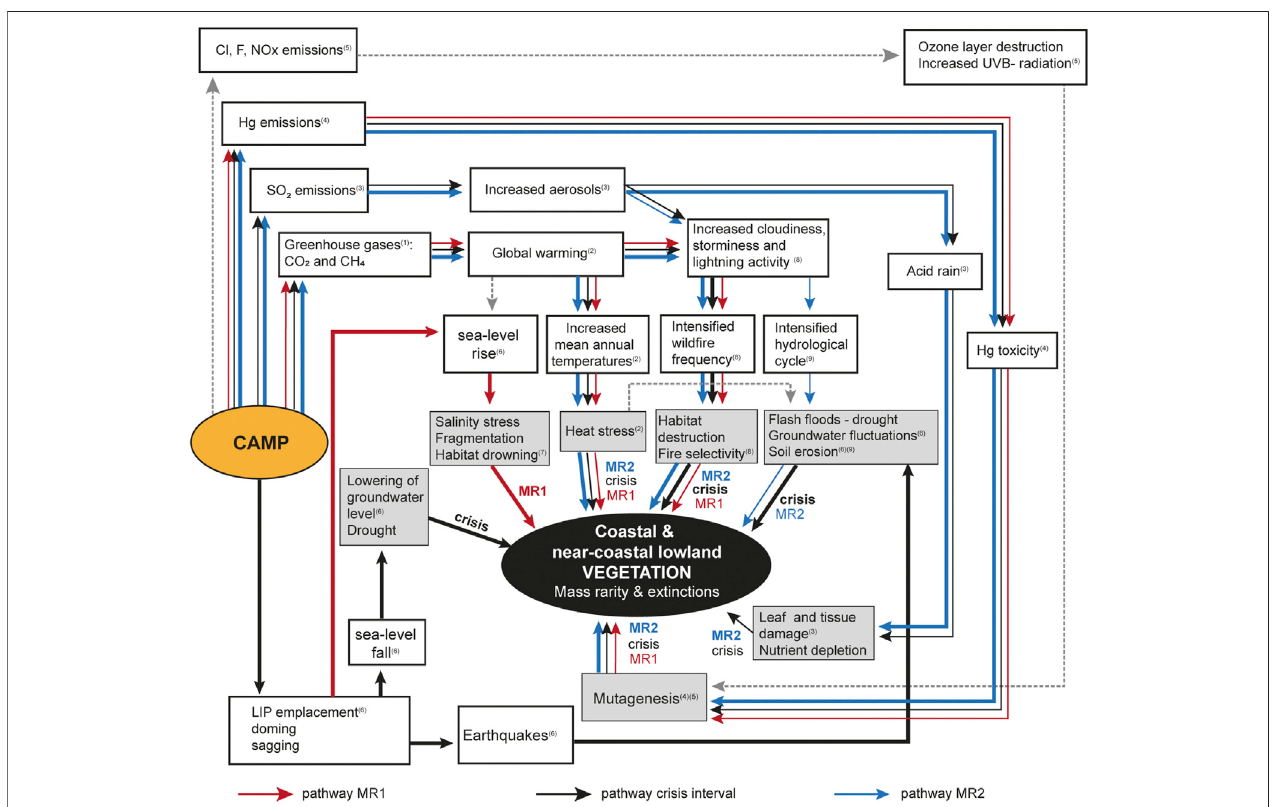
FIGURE 6 | Flow chart illustrating cause-and-effect relationships between the CAMP and the terrestrial vegetation. White boxes exemplify causes and primary physical effects of these, while secondary effects (physiological or directly affecting habitats) are marked with grey boxes. Different coloured arrows illustrate known or hereinhypothesizedpathways:redarrows (cid:1) MR1;blackarrows (cid:1) crisisinterval;andbluearrows (cid:1) MR2.Thethicknessofthearrowsemphasizesimportanceduringthe different intervals, with thicker lines being more important. Grey stippled arrows illustrate hypothesized pathways not discussed in detail in the text. Numbers in brackets refer to references that either hypothesise or have shown these possible pathways: 1) Hesselbo et al. (2002), Ruhl et al. (2011), Capriolo et al. (2021); 2) McElwain et al. (1999), Steinthorsdottir et al. (2011); 3) Guex et al. (2004), Lindström et al. (2012), Callegaro et al. (2014), Steinthorsdottir et al. (2018), Landwehrs et al. (2020);4) Thibodeau et al.(2016), Percival et al.(2017), Lindström et al.(2019);5) Heimdal et al.(2019), Benca et al.(2018); 6)Hallam and Wignall(1999), Hallam (1997), Nielsen (2003), Lindström et al. (2015), Weibel et al. (2016); 7) this paper; 8) Belcher et al. (2010), Petersen and Lindström (2012); 9) Steinthorsdottir et al. (2012), van de Schootbrugge et al. (2020).